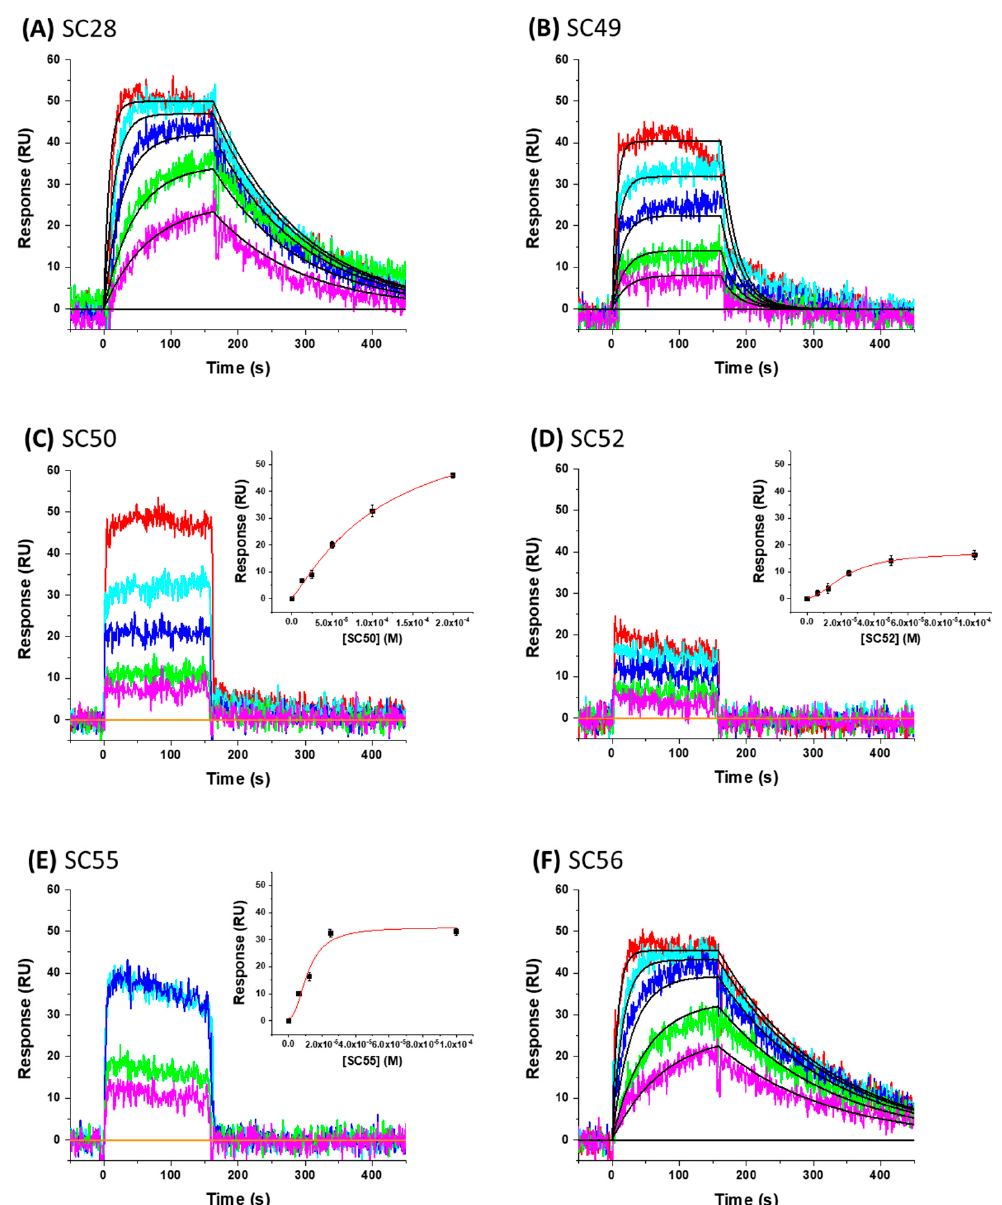
Figure 6. Sensorgrams showing the interaction of small molecule compounds with B41 SOSIP.664 gp140 trimer immobilized on the sensor chip. ( A ) SC28 (concentrations shown are 10 µM and down in a 1:2 dilution series), ( B ) SC49 (100 µM, 1:2 dilution series), ( C ) SC50 (200 µM, 1:2 dilution series), ( D ) SC52 (100 µM, 1:2 dilution series), ( E ) SC55 (100 µM, 1:2 dilution series), and ( F ) SC56 (10 nM, 1:2 dilution series). Colored lines represent actual data, whereas black lines indicate the fits to a 1:1 interaction model. Interaction parameters derived from five sets of data are given in Table 2. Table 3. Kinetics and affinity of novel SC28 derivatives binding to soluble, cleaved recombinant Env. N.D. = not determined.